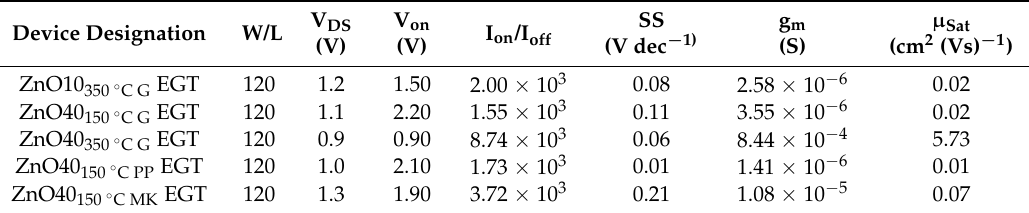
Table 1. Summary of the electrical characterization of the produced fully printed ZnO NP EGTs: channel width and length ratio (W/L), the drain voltage (V DS ), the turn on voltage (V on ), the on-off current ratio (I on /I off ), the subthreshold swing (SS), the transconductance (gm), and the saturation mobility ( µ Sat ).